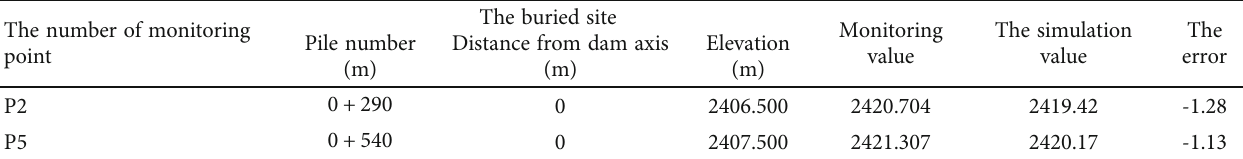
Table 2: The comparison of seepage pressure at monitoring points P2and P5.